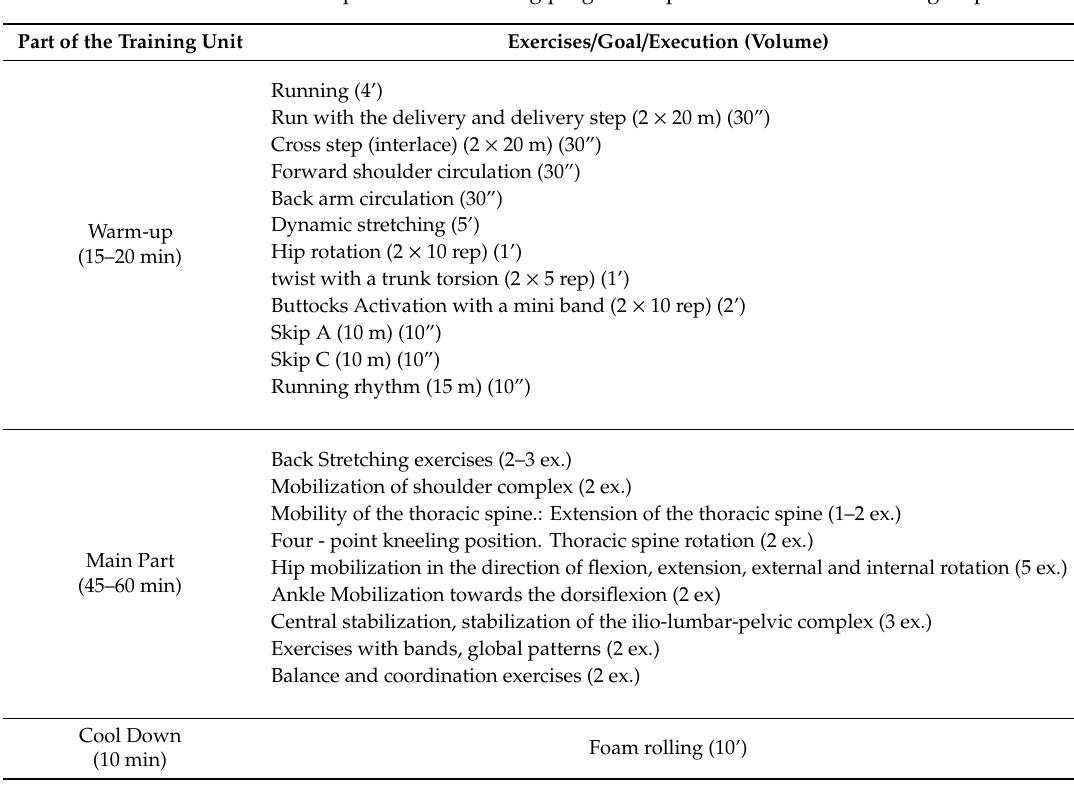
Table 2. A detailed description of the training program implemented in the research group.